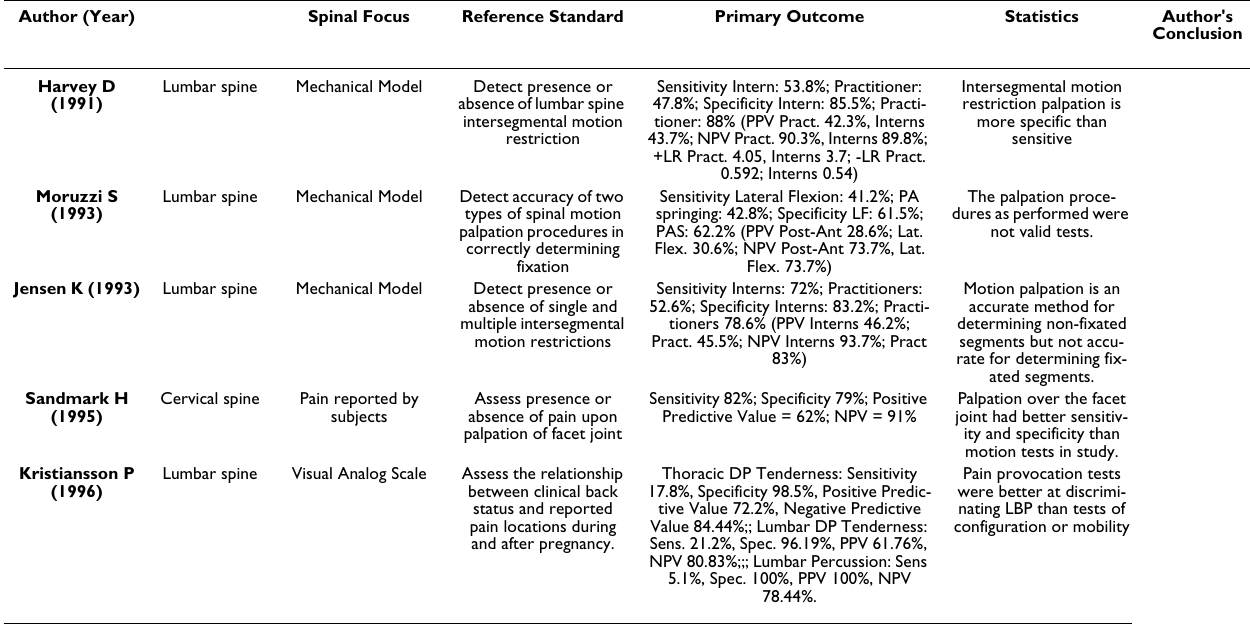
Table 6: Spinal focus of the study, Reference standard used, Primary outcome, Statistics, and Author's